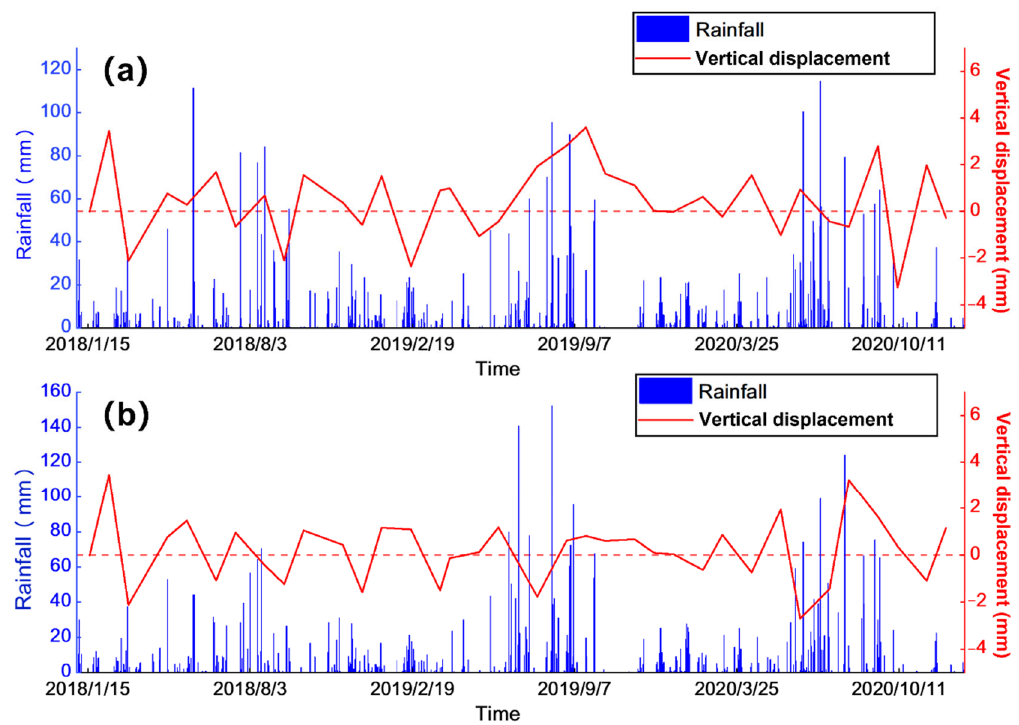
Figure 10. Regional rainfall versus average accumulated deformation. ( a , b ) are rainfall variation maps of two meteorological observation points in Shanghai.